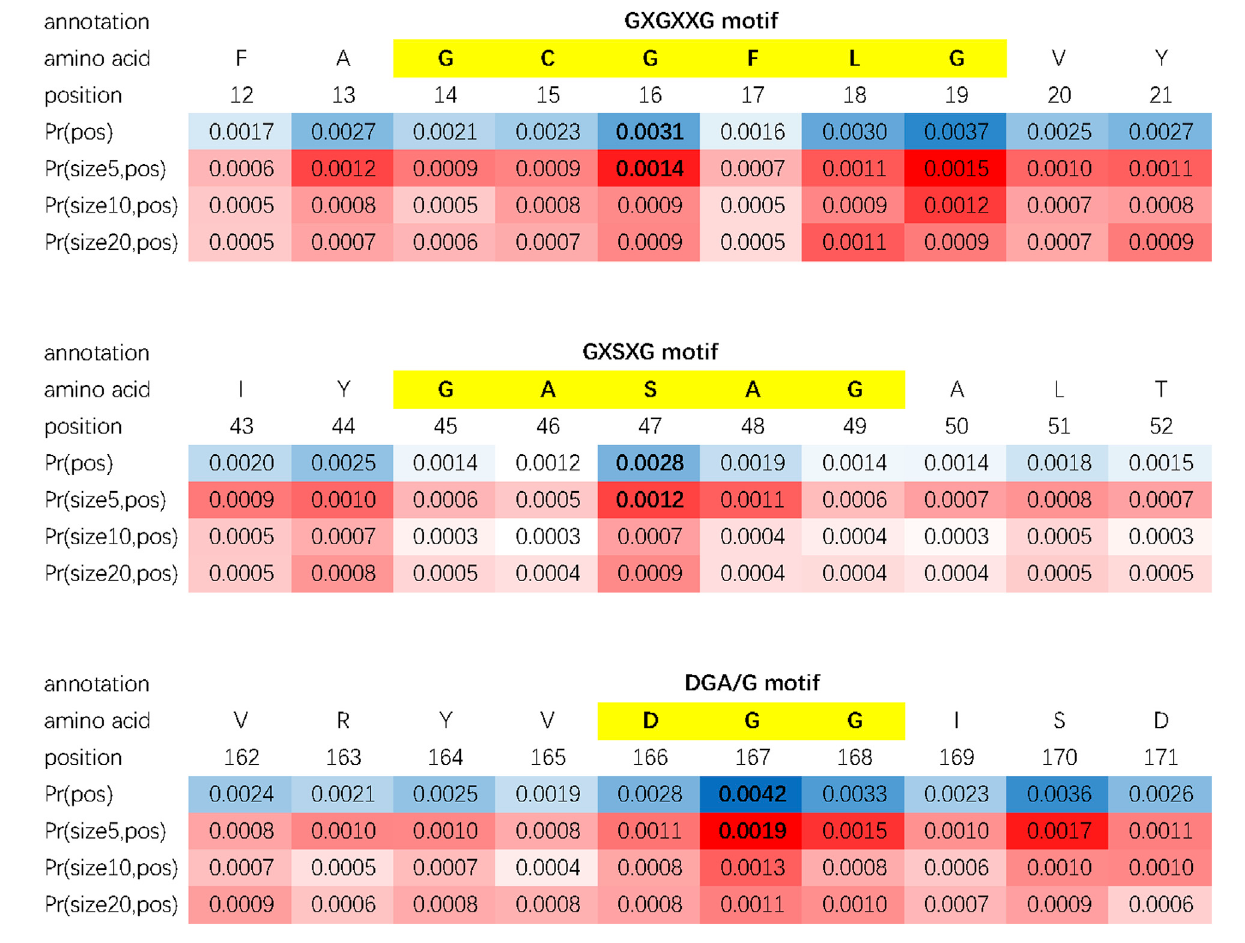
FIGURE 3 | Three matched motifs belonging to the PNPLA